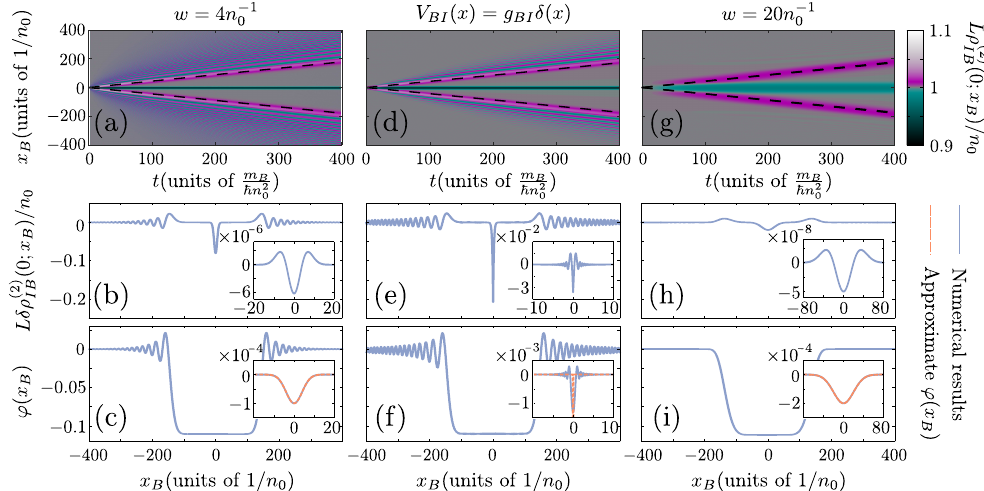
Figure A2. Emergence of dispersive shock waves for short-range interaction potentials. ( a ) Spatiotem- ( 2 ) ( 0; x ) for g f = 0.1¯ h 2 n = g = 0, L = 1600 n − 1 poral evolution of ρ and N B = 1600 B BB , p I 0 / m B IB BI 0 in the case that a Gaussian bath-impurity interaction potential with width w = 4 n − 1 is employed. 0 ) . ( c ) the phase profile correspond- ( b ) Same as ( a ) but for the particular time instant t = 300 m B / ( ¯ hn 2 0 ) . ( d – f ) correspond to the same quantities ing to ( b ). The insets of ( b , c ) correspond to t = 0.1 m B / ( ¯ hn 2 0 as in ( a – c ) respectively, calculated for the same set of parameters. However, here the bath-impurity potential corresponds to δ -function. ( g – i ) the same quantities as in ( a – c ) but for a wider Gaussian potential w = 20 n − 1 . The insets of ( c , f , i ) in addition to the GA numerical results also indicate the 0 approximate profile expected from the phase imprinting of the impurity potential (see